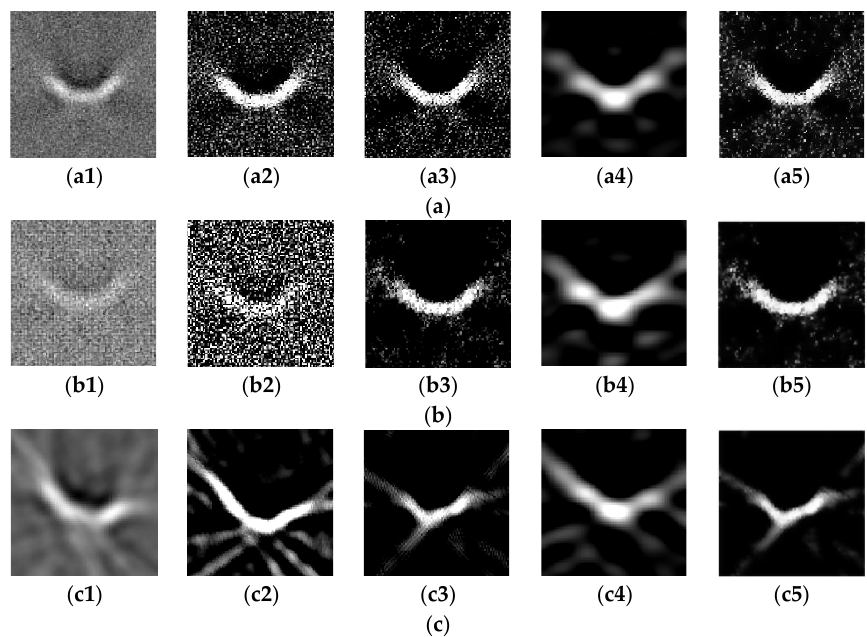
Figure 12. Far-field experimental imaging results ( Far left ) iRadon; ( Left ) FBP; ( Middle ) ART; ( Right ) sparse ART with OMP; ( Far right ) TV sparse reconstruction with ART. ( a ) Complete view data with noise (a1:a5); ( b ) sampled data at 10° intervals with noise (b1:b5); ( c ) random sampled data at 10° intervals (c1:c5). Table 5. IE, NRSNR, and Var value of anti-noise and random sampled results.